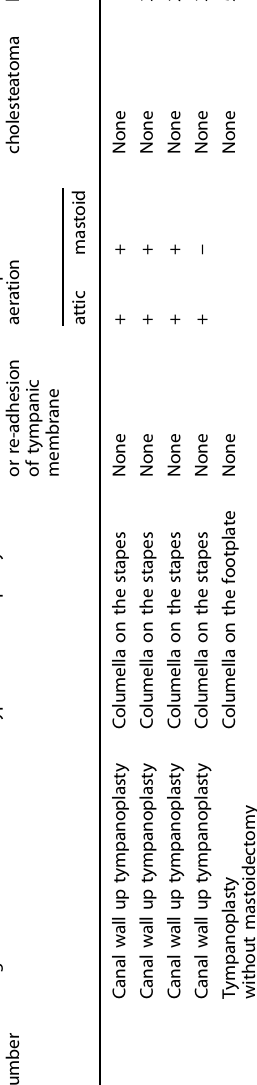
of tympanic membrane adhesion and cholesteatoma. In this study, the percentage of cytokeratin-positive cells was quantitatively analyzed by fl ow cytometry and the results showed that the purity of epithelial cells in the cultured cell sheets was higher than 80%.We considered the epithelial cells were main population of cell sheets because the all layers of fabricated cell sheets expressed pan-cytokeratin in this study. Although it is necessary to investigate whether the transplanted cells remain in future, in previous animal study, we could observe the cells with T a